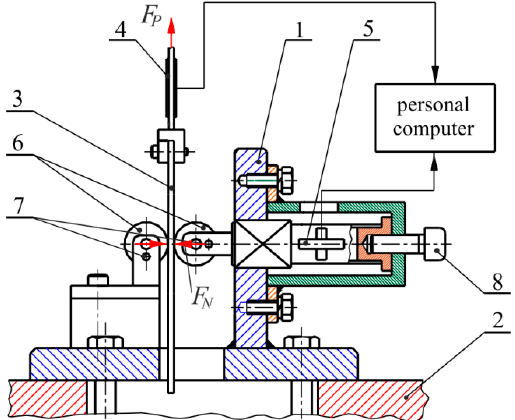
Figure 5. Schematic representation of the measuring device for strip drawing test (SDT): 1—Frame; 2—Support table; 3—Specimen; 4—Vertical load cell; 5—Horizontal load cell; 6—Working rollers; 7—Blocked pins; 8—Set bolt.